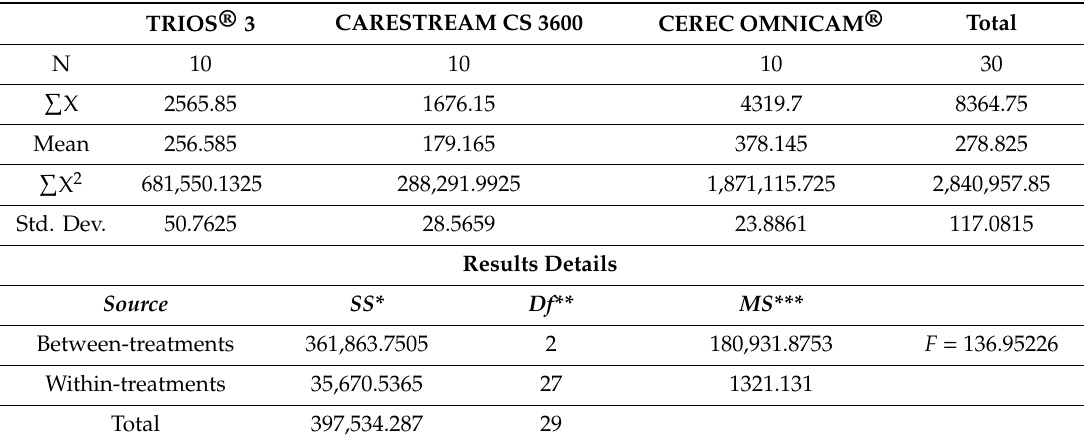
Table 4. Distance between reference lines and test ones in sample 3 with saliva.